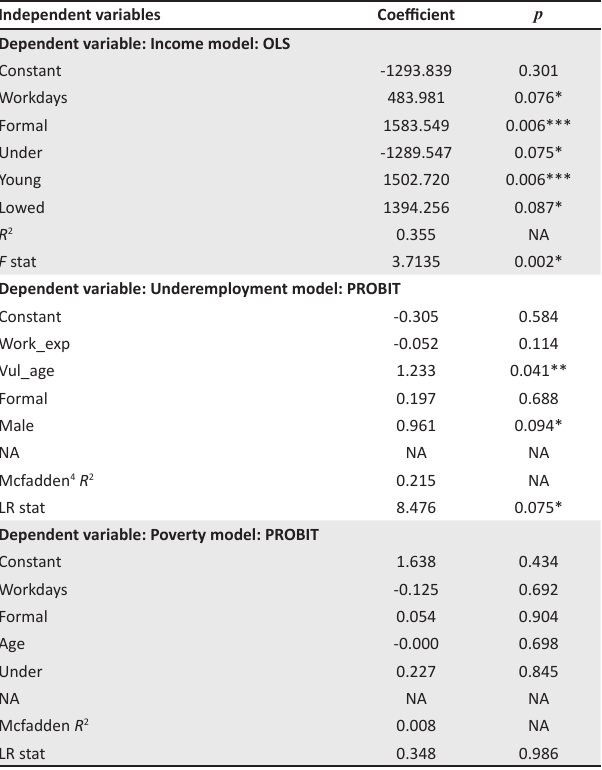
TABLE 3: Car guarding: Income effects, determinants of underemployment and likelihood of increased poverty. Independent variables